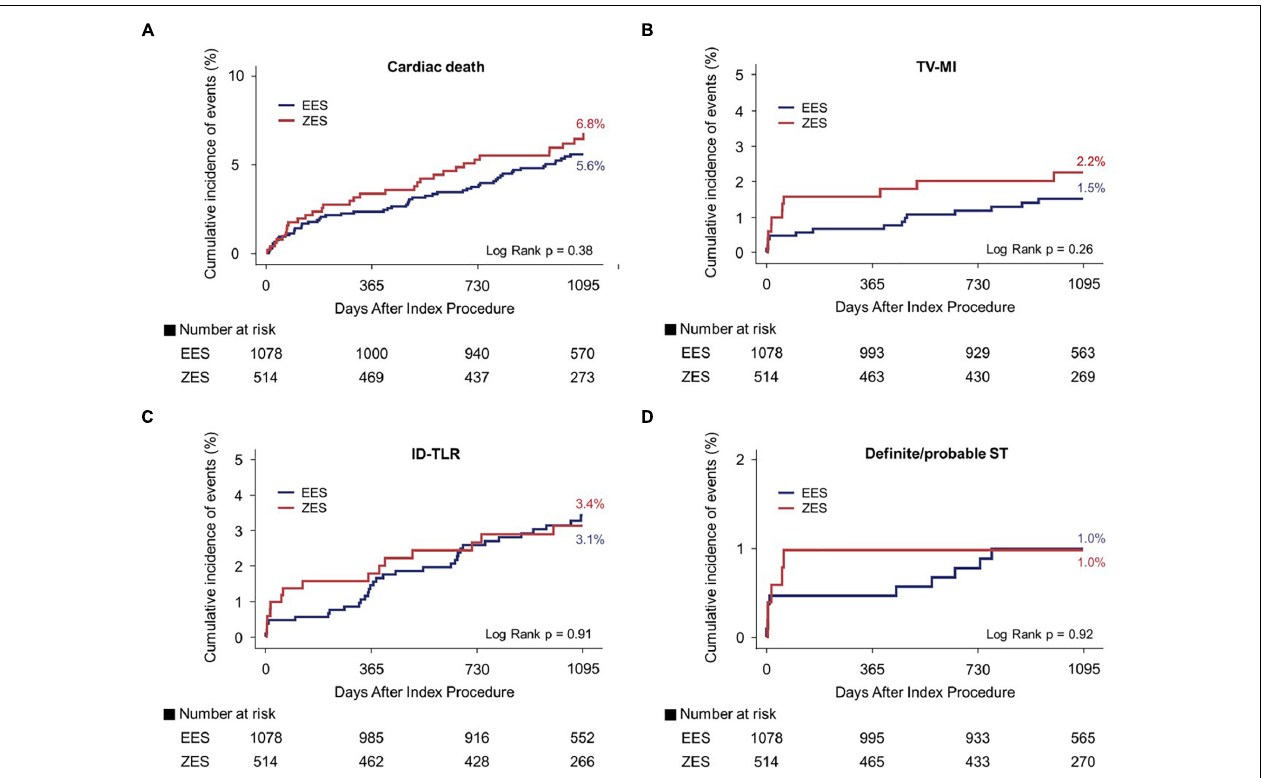
FIGURE 4 | Kaplan–Meier curves for 3-year cardiac death, TV-MI, ID-TLR, and definite/probable ST. Cardiac death (A) , TV-MI (B) , ID-TLR (C) , and definite/probable ST (D) . TV-MI, target vessel myocardial infarction; ID-TLR, ischemic-driven target lesion revascularization; ST, stent thrombosis; EES, everolimus-eluting stent; ZES, zotarolimus-eluting